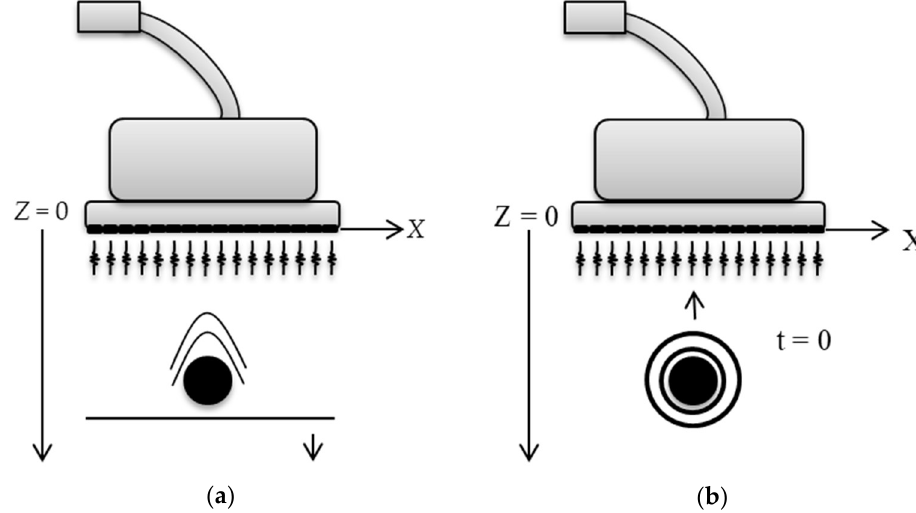
Figure 6. Representation of the echo signal using ( a ) the traditional model, and ( b ) according to the ERM model.